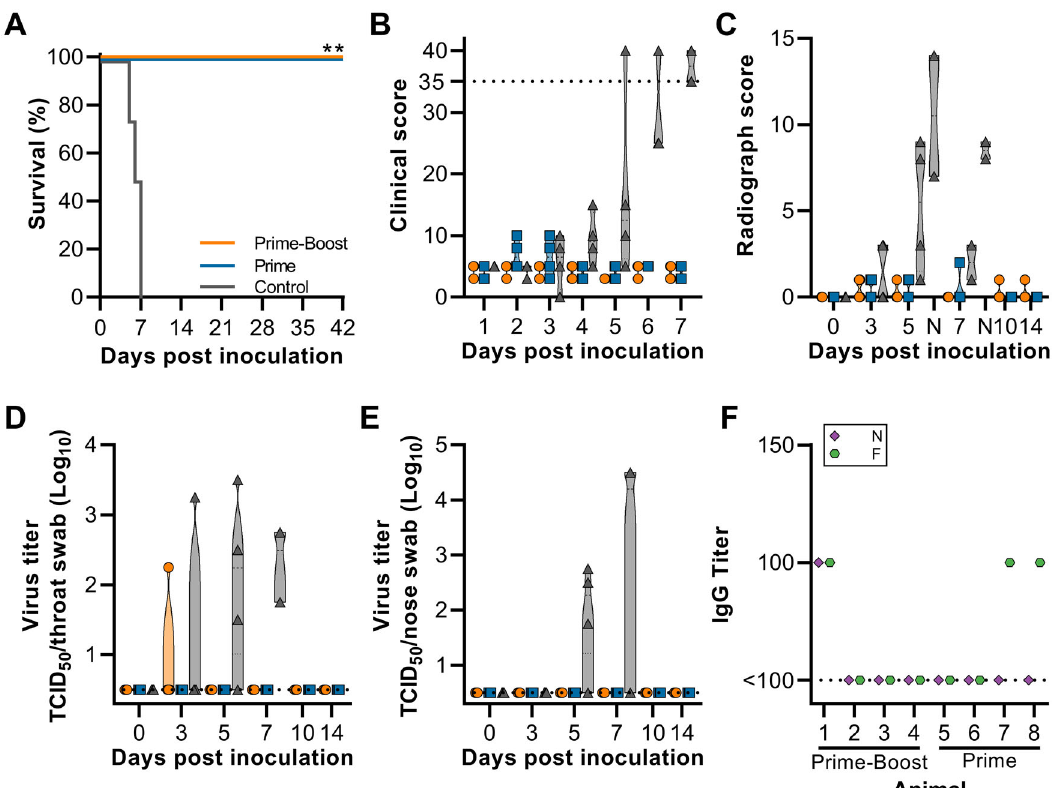
Fig. 2 Clinical signs and NiV detection in vaccinated AGMs upon virus challenge. 28 days post fi nal vaccination, AGMs ( N = 4 per group) were inoculated with NiV-B and monitored for up to 42 days. A Survival of AGMs. B Truncated violin plot of daily clinical score. Dotted line indicates humane endpoint score requiring euthanasia. C Truncated violin plot of thoracic radiograph scores on exam days and day of euthanasia (N, controls only). D , E Truncated violin plots of infectious NiV in throat swabs ( D ) and nose swabs ( E ). At 7 DPI, only 2 control animals were part of the study. Dotted line indicates limit of detection. F Truncated violin plot shows no or very low (1:100 dilution) evidence of NiV- nucleoprotein (N, purple diamond) or NiV-fusion glycoprotein (F, green octagon) -speci fi c IgG in serum at 42 DPI. Dotted line indicates limit of detection. For all panels, orange indicates prime-boost vaccinated animals, blue indicates prime-only vaccinated animals, and gray indicates control